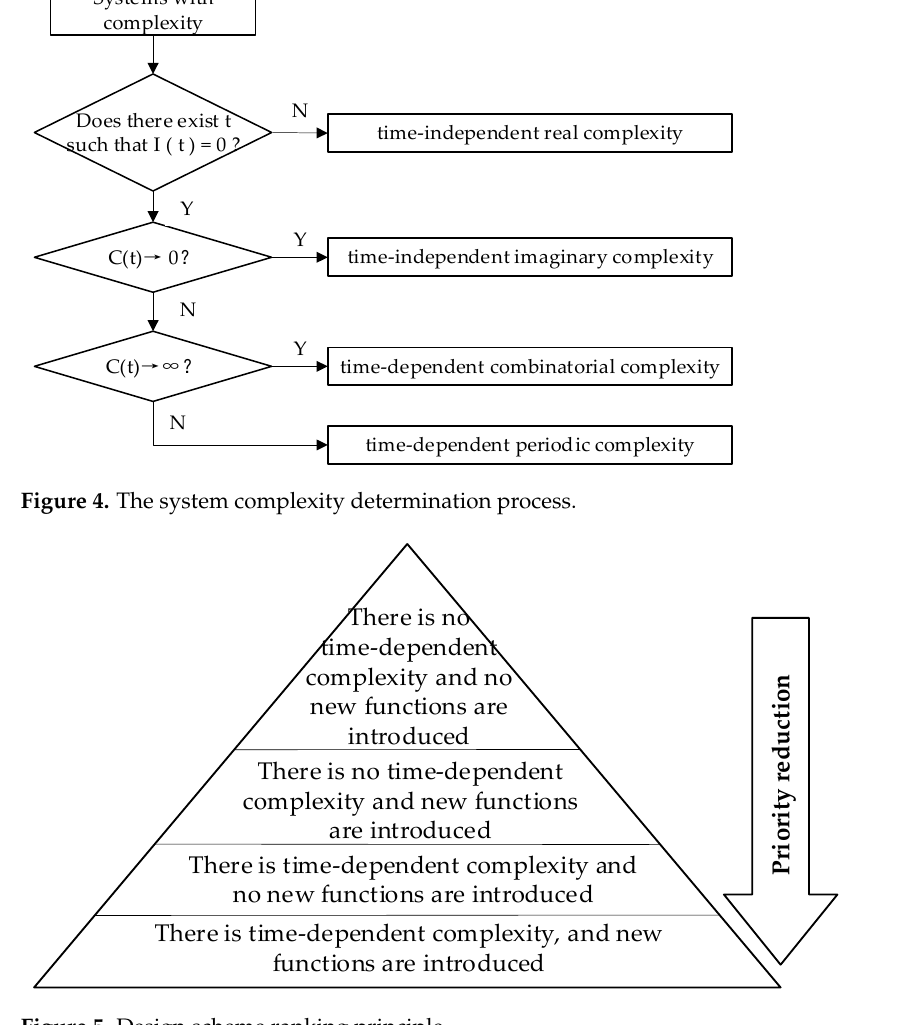
Figure 5. Design scheme ranking principle.